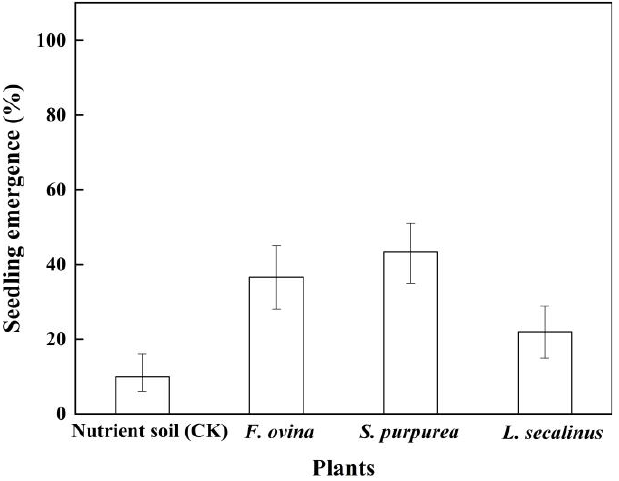
Figure 7. Seedling emergence (±95% binomial confidence intervals) of P. kansuensis treated with transplantation of different native dominant plants.